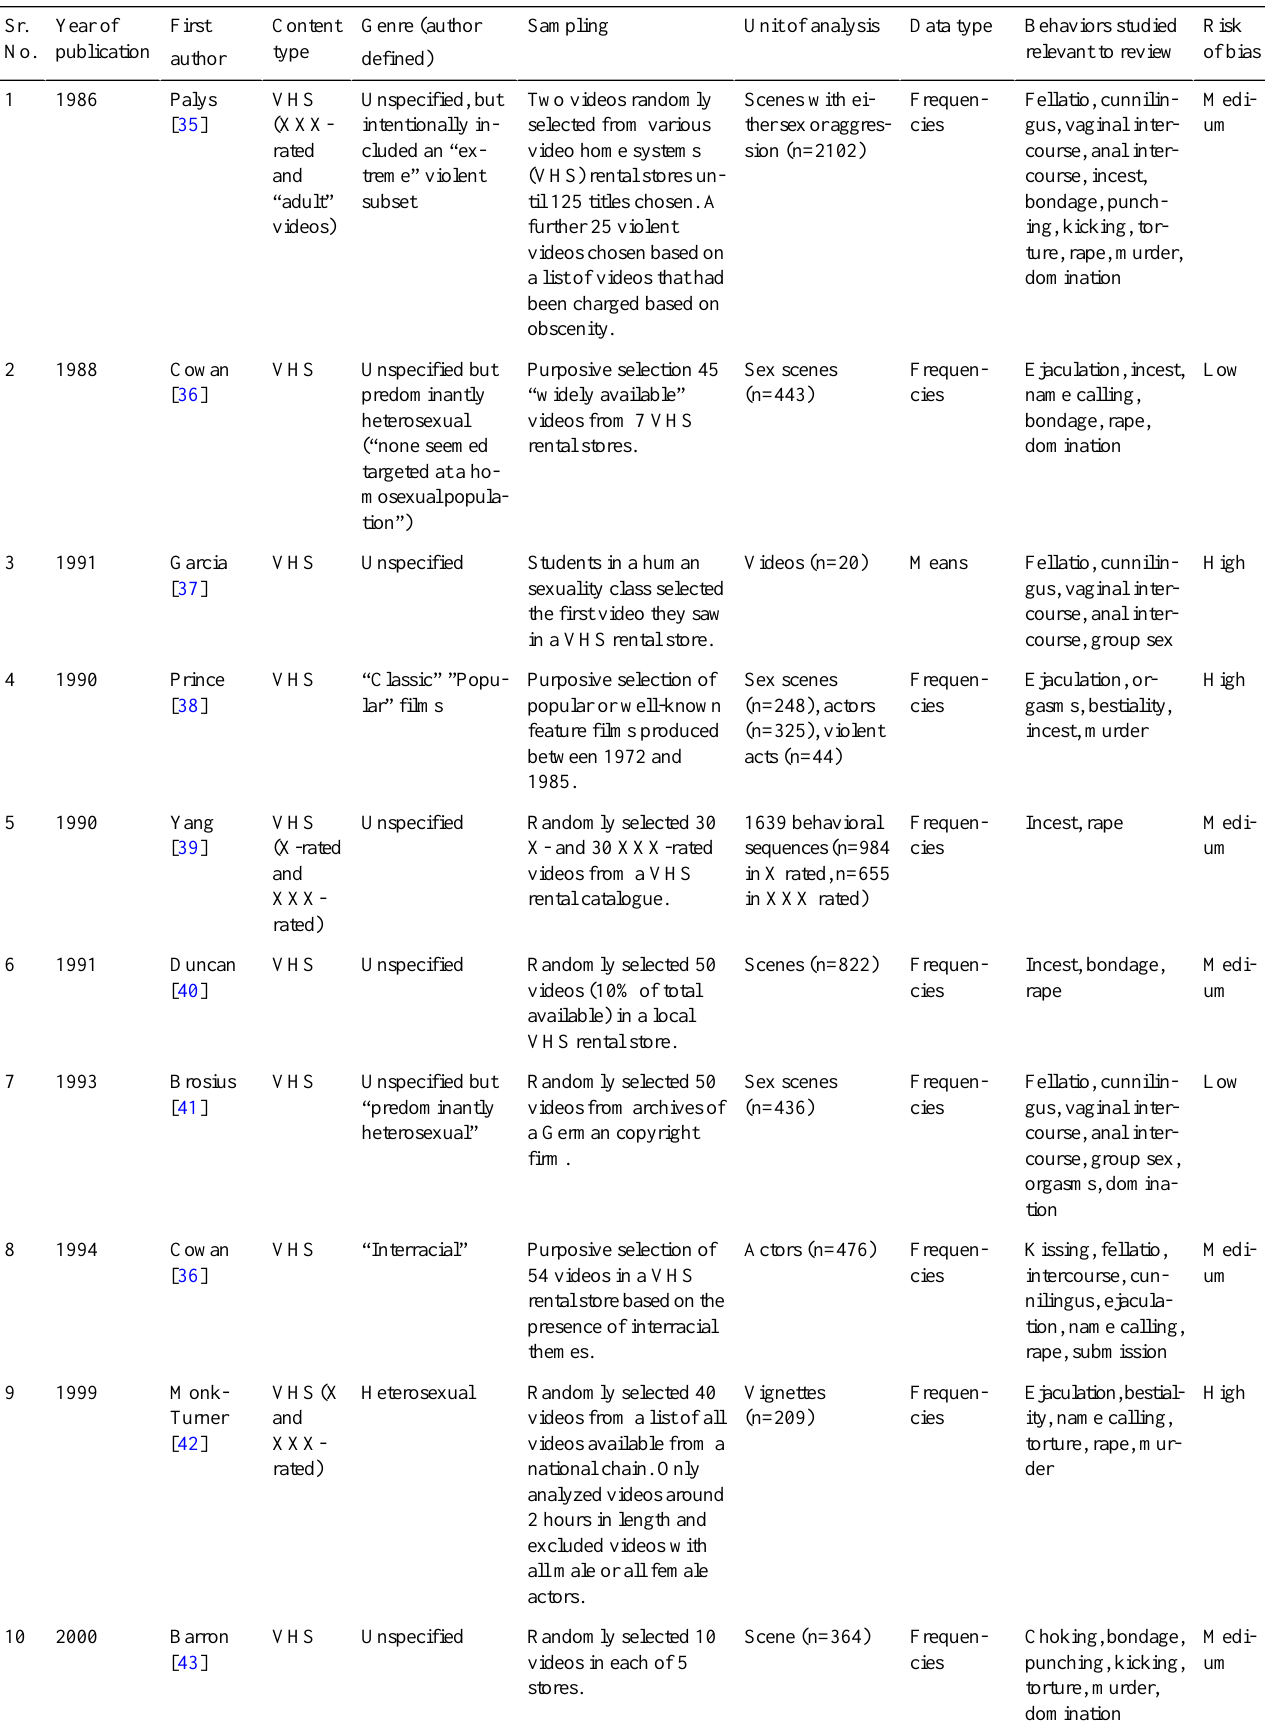
Table 2. Characteristics of content analyses identified in the review, by year of